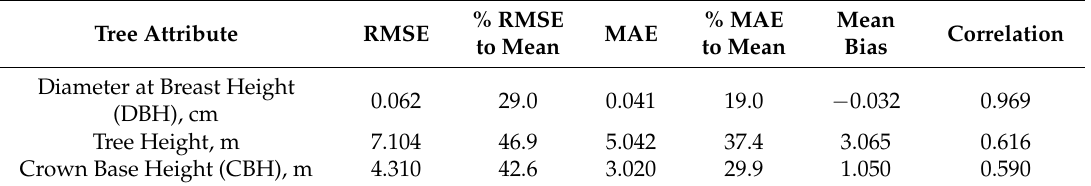
Table 2. RMSE, MAE Bias and correlation estimates for DBH, tree height and CBH *. Tree Attribute RMSE